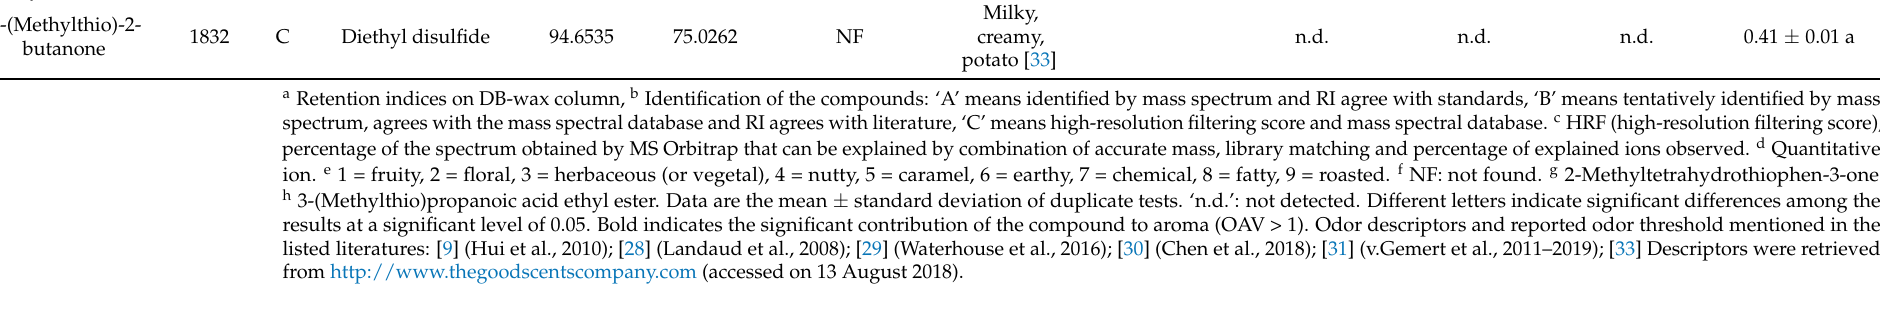
Table 3. Concentration, odor threshold, odor descriptor and odor series of individual volatile compounds in passion fruit wine fermented by commercial